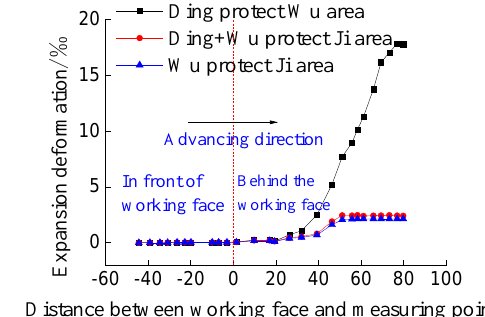
uring gas pressure point test data; ( c ) NO. 1 measuring point permeability coefficient test data; ( d )